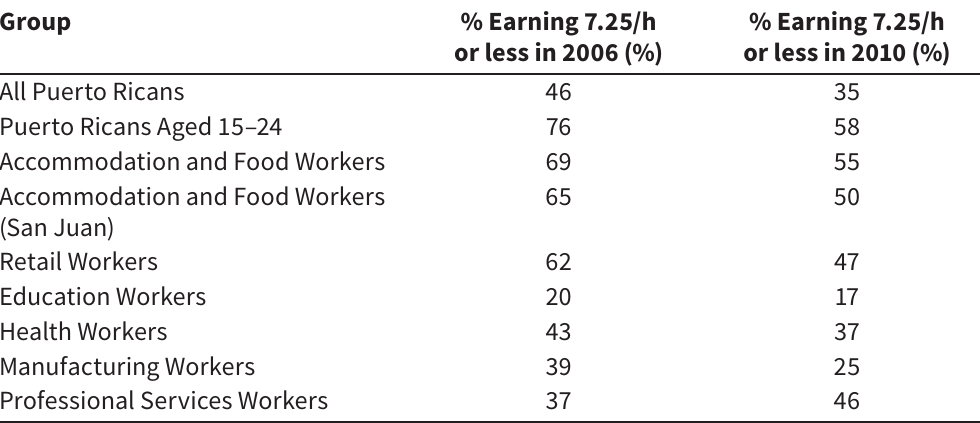
Bite of the Minimum Wage Across Groups